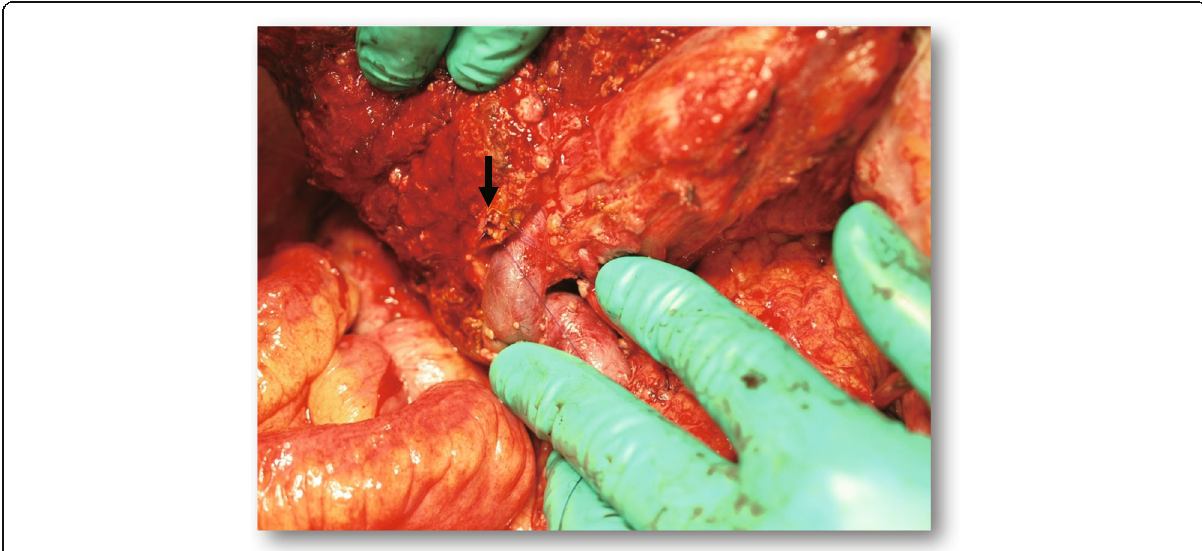
Fig. 4 Completion photograph after resection. Extended right hepatectomy, extrahepatic bile duct resection, and partial resection of the duodenum and colon were performed. Arrow indicates the stump of the intrahepatic segmental bile ducts